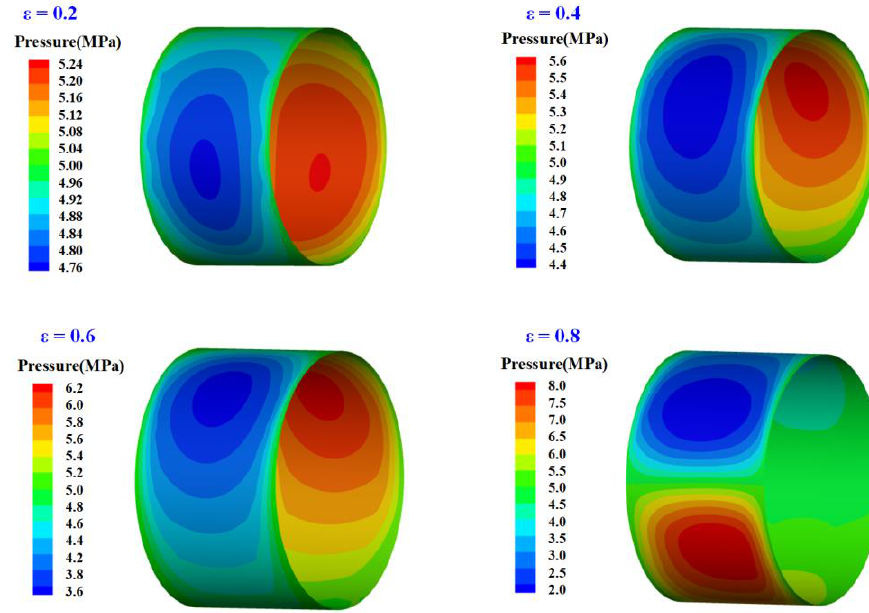
Figure 9. Magnetic fluid lubrication film pressure distribution.